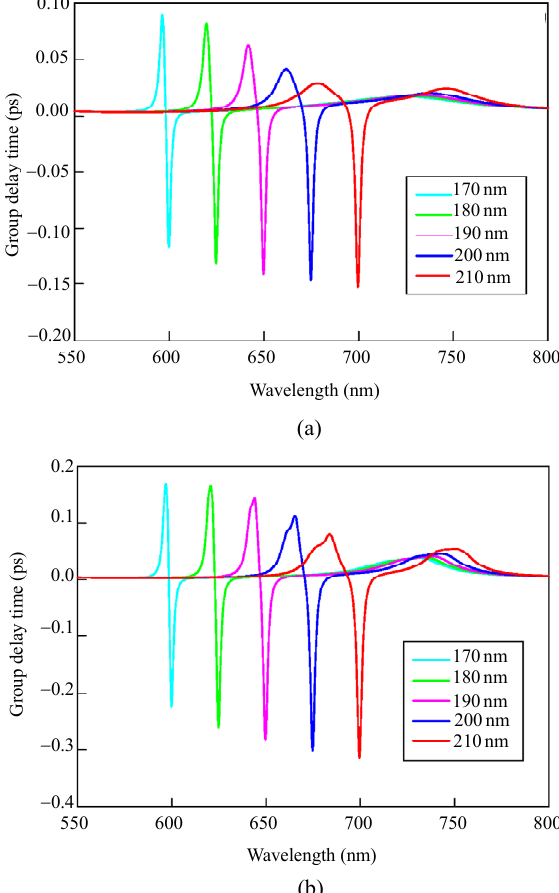
Fig. 6 Group delay time versus L arc for (a) the non-cascading device and (b) cascade